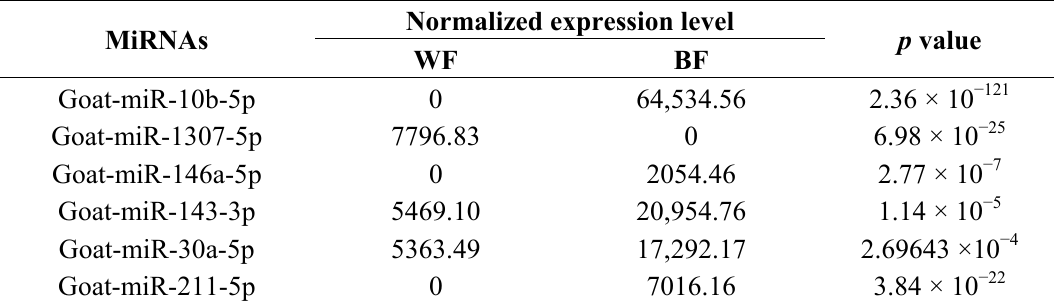
Table 4. Differentially expressed miRNAs among different goat follicle